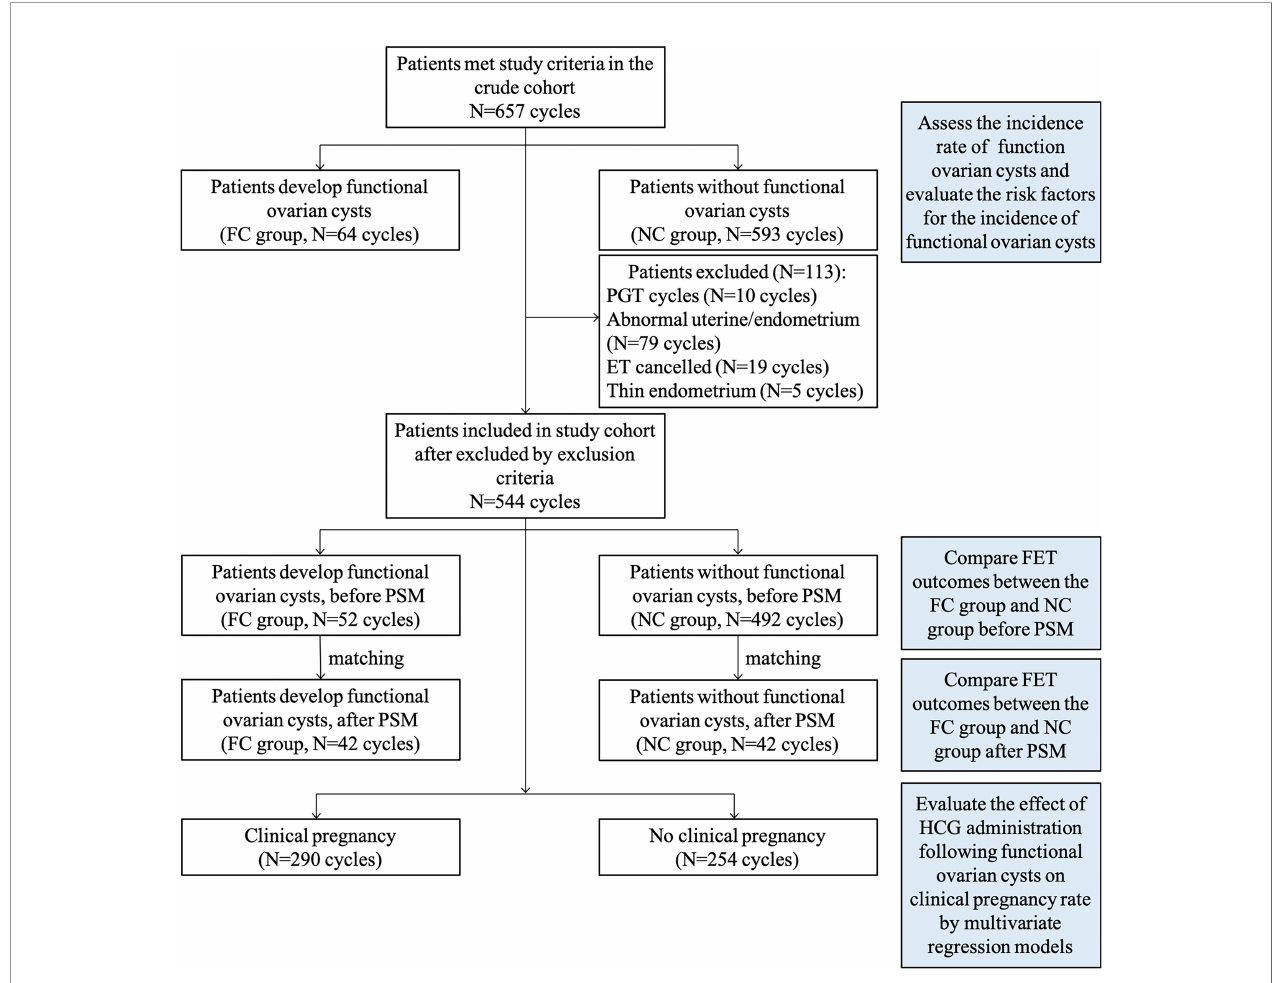
FIGURE 1 | The fl owchart of the